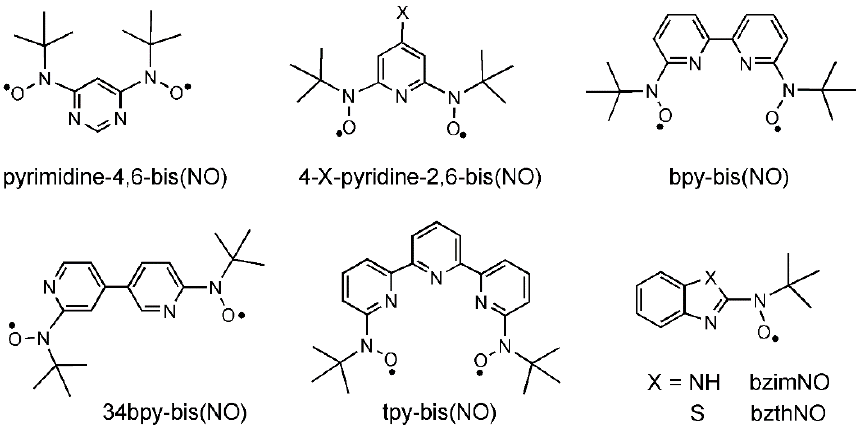
Figure 17. Structural formulas and abbreviations of 2-azaaryl tert -butyl nitroxides.